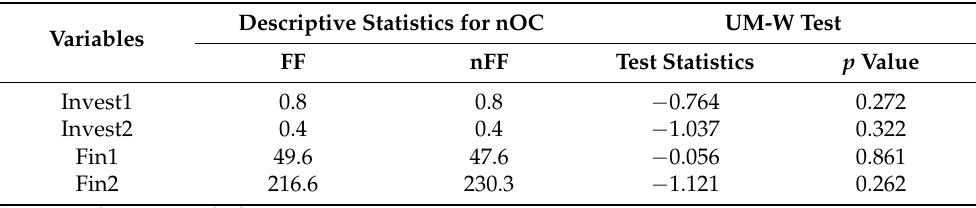
Table 4. Descriptive statistics describing investment and financing strategy in subsamples for non- overconfident CEOs.